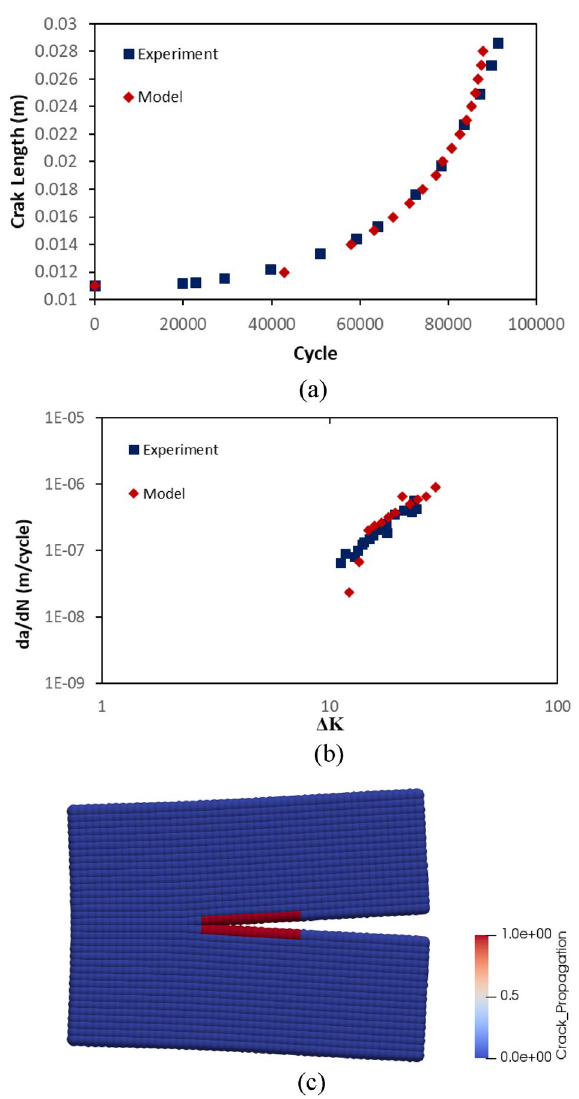
Figure 12. Results for rail steel model. ( a ) A comparison between the experiment and PD simulation in terms of crack length vs cycle. ( b ) A comparison between the experiment and PD simulation in terms of crack growth speed vs stress intensity factor. ( c ) A picture of crack propagation after 83 k cycles from PD